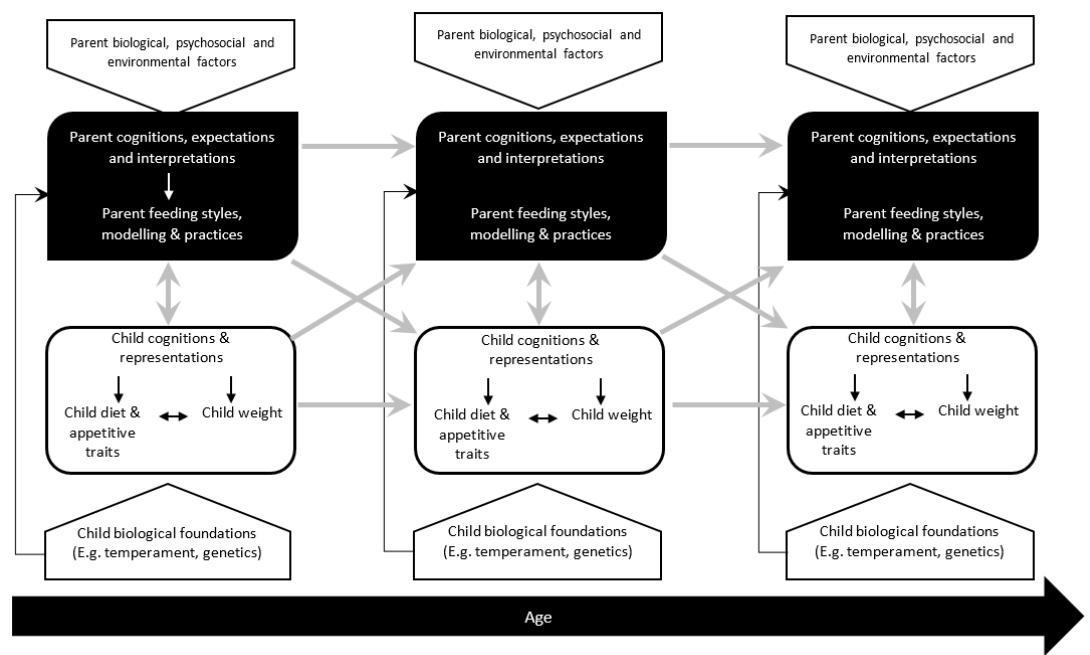
Figure 1. A model of biological and psychosocial processes in the early development of children’s eating and weight.